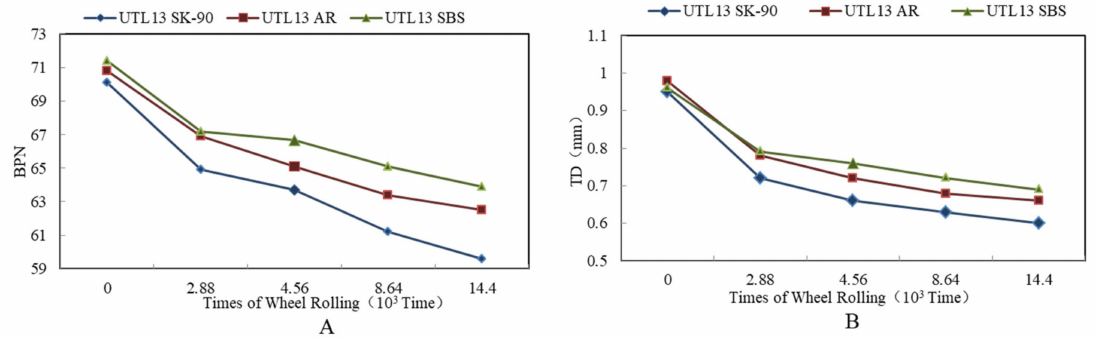
Figure 13. Attenuation rules of skid resistance indexes with di ff erent asphalt binder types: ( A ) BPN; ( B )